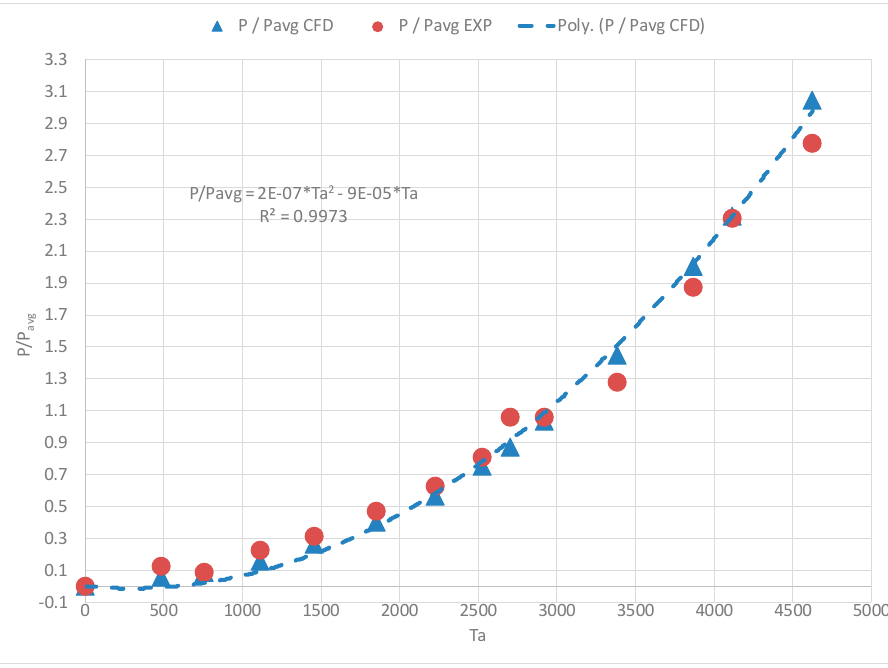
Figure 17. Experimental and numerical windage for Re = 1664, P avg CFD = 59.31 W and P avg Exp. = 57.4 W.